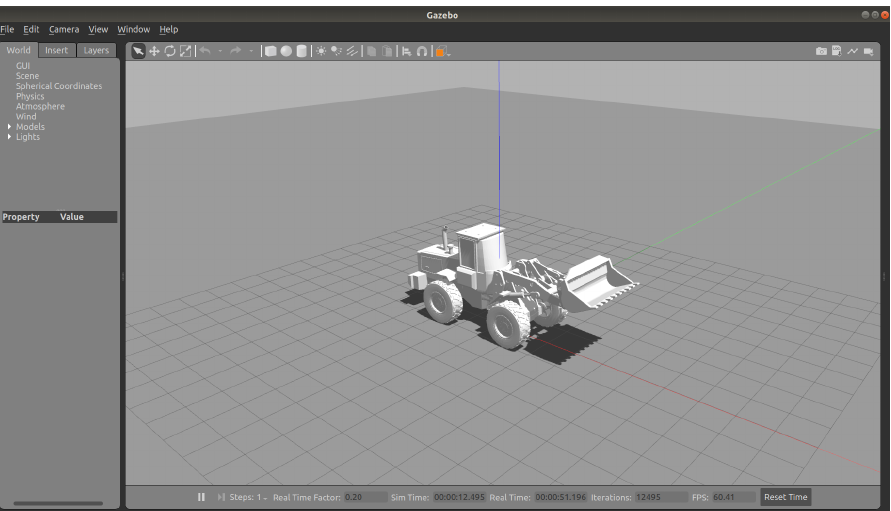
Figure 2. Wheel loader model in Gazebo: once the models had been developed in Solidwork, they were converted to Unified Robotic Description Format (URDF), using a 3rd party URDF conversion tool called “ sw_urdf_exporter ”, which allows for conveniently exporting SW Parts and Assemblies into a URDF file. Gazebo enables us to obtain sensors’ simulation such as IMUs, GPSs, encoders, cameras, and stereo cameras through gazebo_plugins , which can be used to attach into ROS messages and service calling the sensor outputs, i.e., the gazebo_plugins create a complete interface (Topic) between ROS and